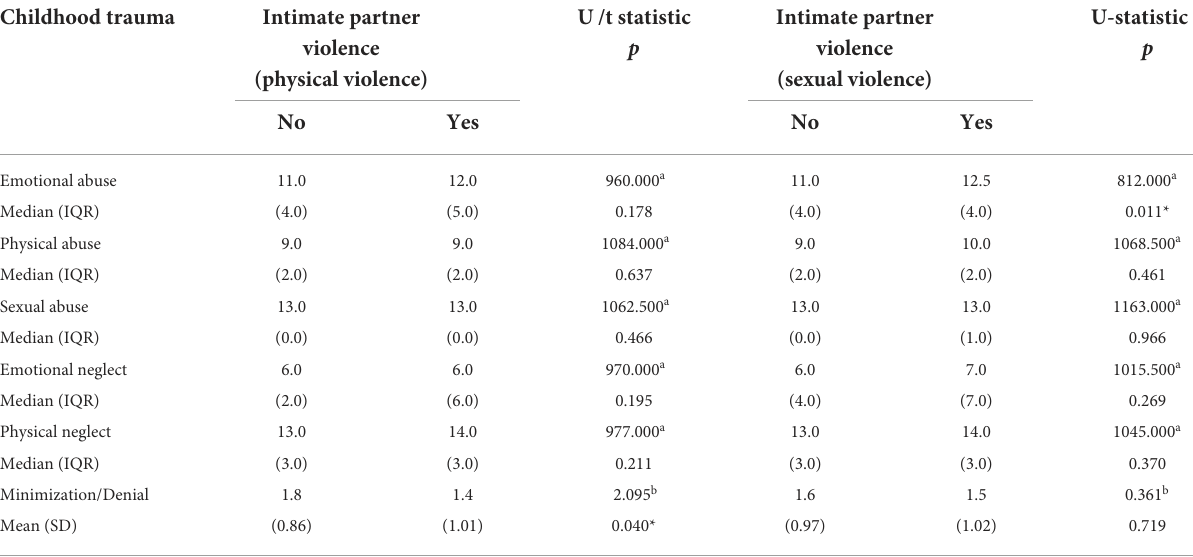
TABLE 2 Association between childhood trauma and intimate partner violence ( n = 105).